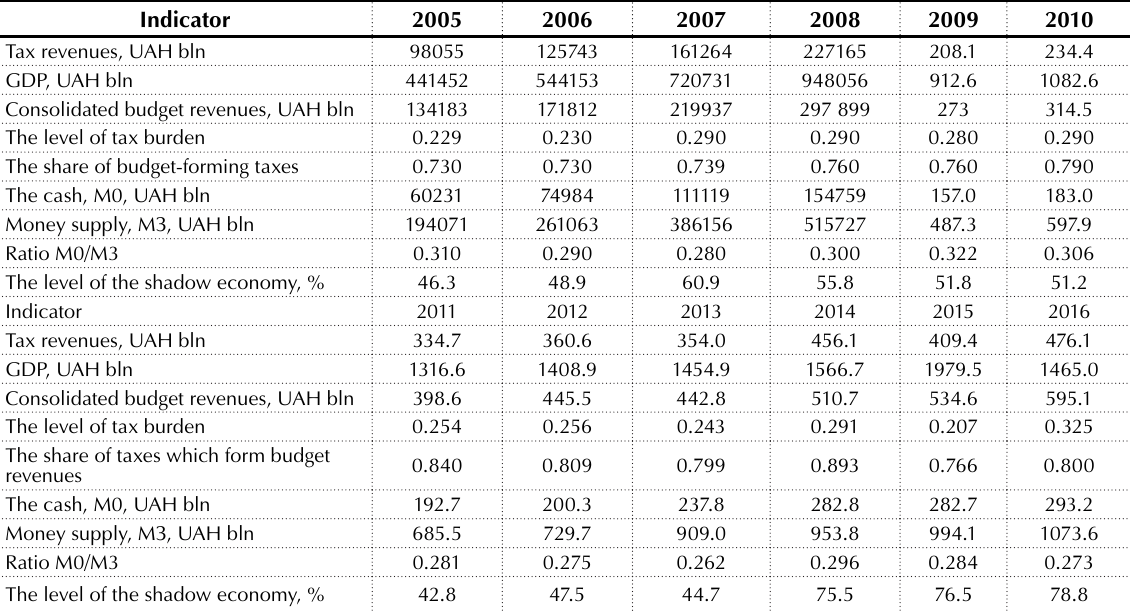
Table 6. Dynamics of calculation indices of the shadow economy of Ukraine estimation in